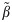
Number of extending pseudopods.(A) Schematic of pseudopod extension as deduced from the analysis of START and STOP. Cn is a cell with n extending pseudopods. The formation of a pseudopod is given by the rate constant α, that is reduced A-fold by each extending pseudopod (see Fig 2). The termination of pseudopod extension is given by the macroscopic rate constant β˜ that is independent of the number of extending pseudopods (Fig 3A and 3B); a cell with e.g. three pseudopods has three possibilities to stop one of its pseudopods, giving 3β˜. (B) Prediction of the number of extending pseudopods using α/β˜ = 2.0, and different values of A. (C) Experimental observations for polarized wild-type and two mutants. Equations S17 and S18 in S1 Text in S1 File were used to predict (panel B) or to fit experimental data (panel C); the optimal value and 95% confidence interval for the fitted values of α/β˜ and A are given in S2 Table.